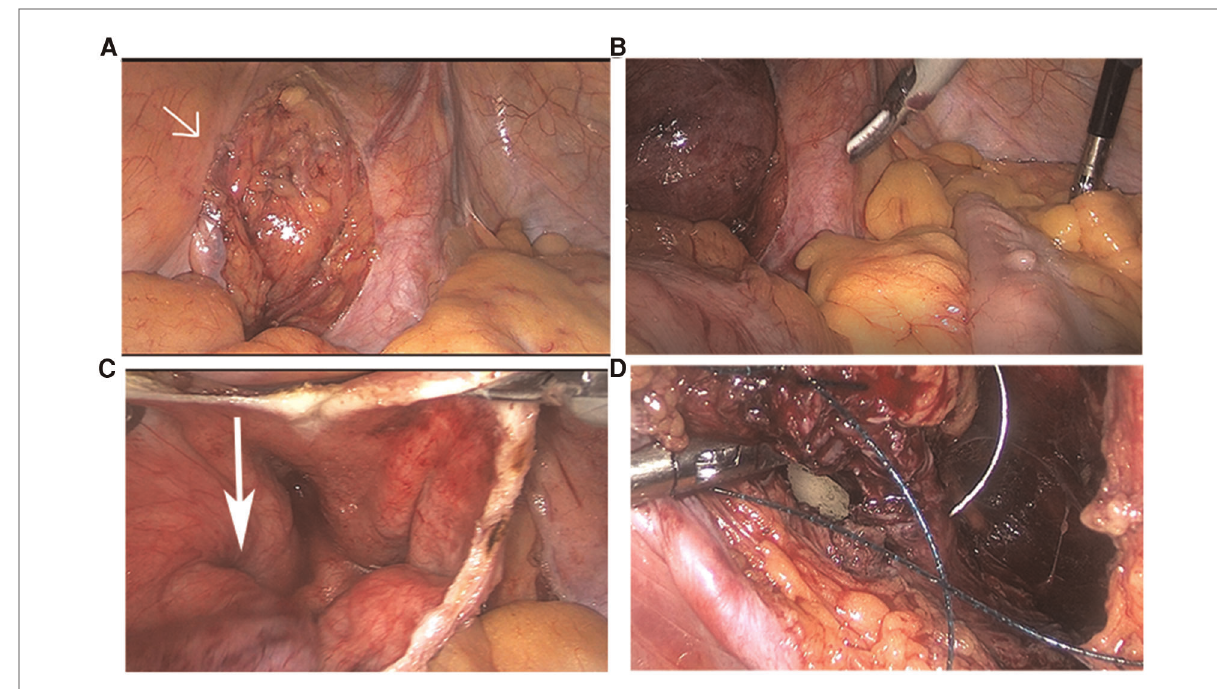
FIGURE 2 The protuberant diverticulum (arrow head) located in the right side of the bladder ( A ). The sigmoid colon located on the right side of the abdominal cavity ( B ). The narrow diverticulum ori fi ce (arrow head) ( C ). Suture the bladder under the guidance of balloon ( D